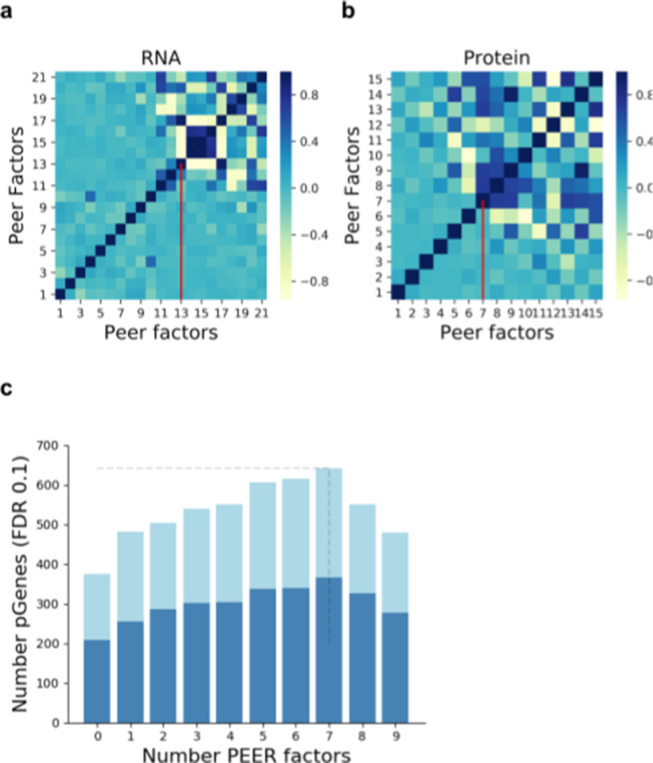
Selection of the number of PEER factors to adjust for unwanted variation.Pairwise correlation (Pearson correlation coefficient) between the Peer factors fitted on RNA (a) and protein data (b). Vertical red lines indicate the number of factors used within this study. (c) Number of genes with a pQTL (FDR < 10%) when accounting for increasing numbers of factors in the analysis. Dark blue denotes pQTLs replicated at RNA level (defined as nominal PV <0.01; Materials and methods).